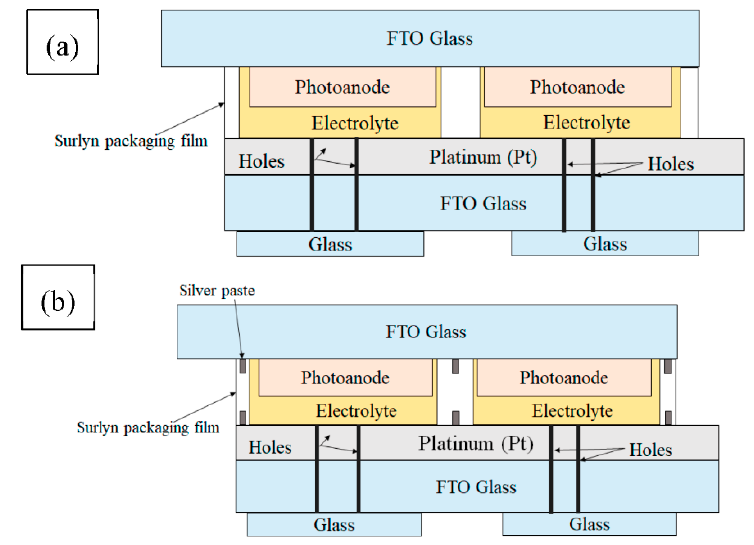
Figure 2. Schematic diagram of ( a ) two parallel and ( b ) two parallel silver-grid DSSCs using zinc oxide (ZnO) nanorod photoanodes (one device exists in a silver-grid).